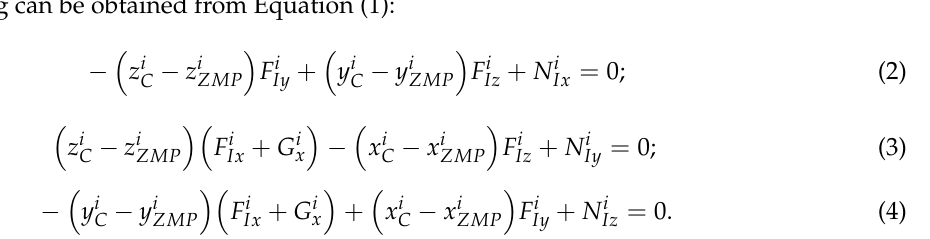
Figure 1. Force-schematic diagram of the robot body.